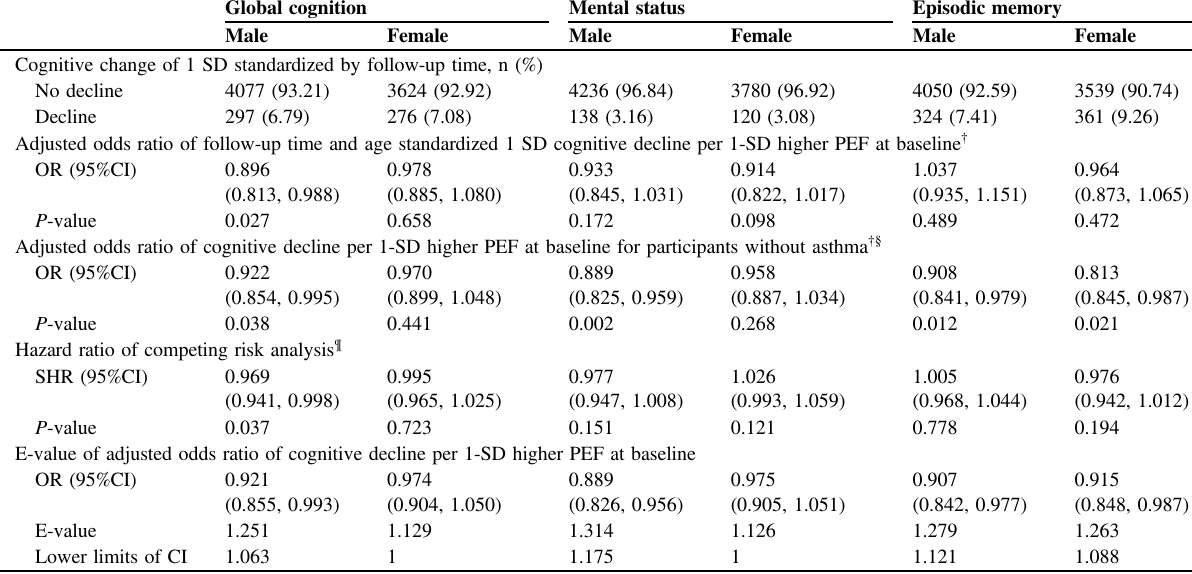
Table 5 Adjusted odds ratio of cognitive decline for PEF across all sensitivity analyses Global